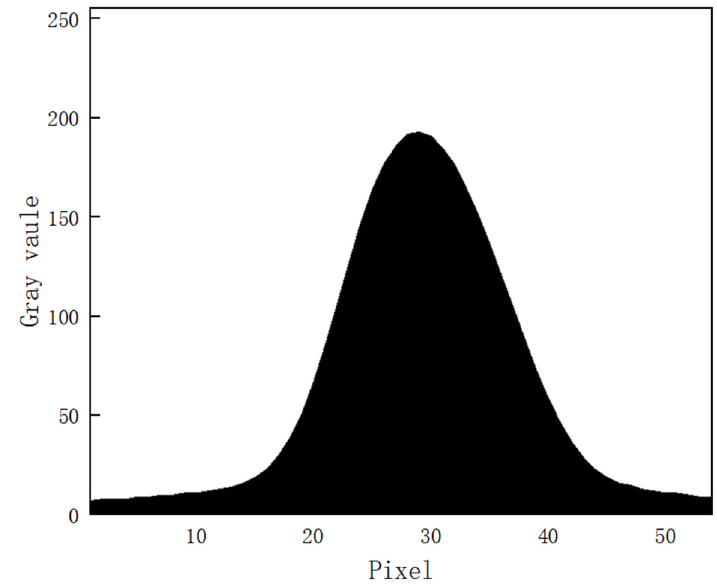
Figure 2. Gaussian distribution of light stripe cross-sections.